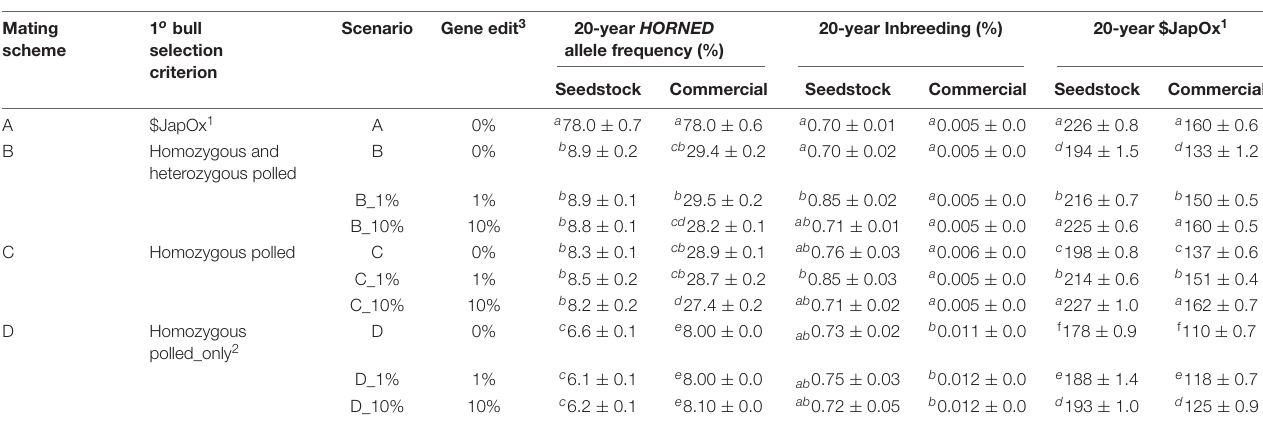
TABLE 1 | Parameters and results of each